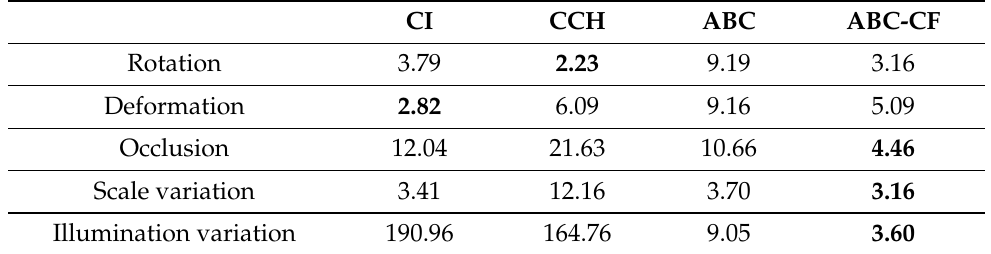
Table 1. Location error comparison with different challenges for color histogram-based approaches.